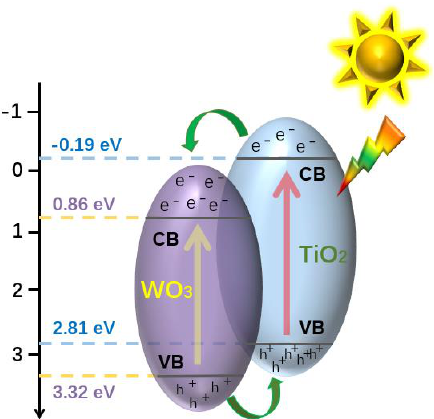
Figure 12. Schematic diagram of photocatalysis in the R-WO 3 /R-TiO 2 /CC